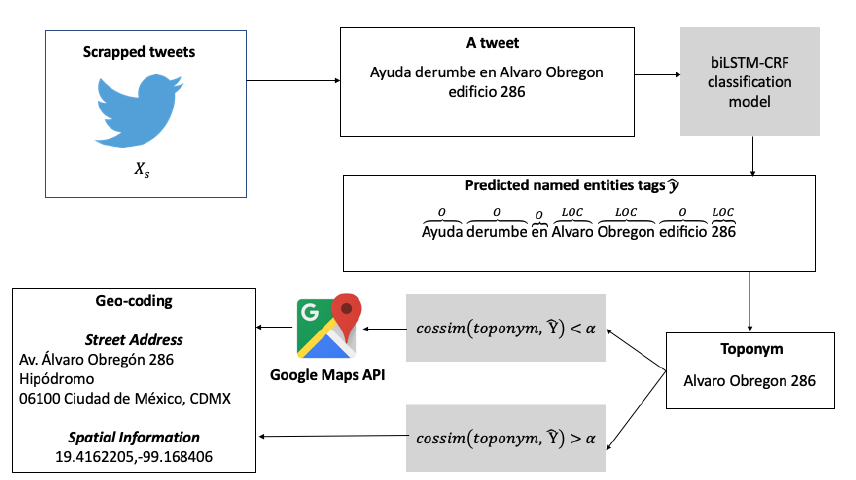
Figure 5. Toponym